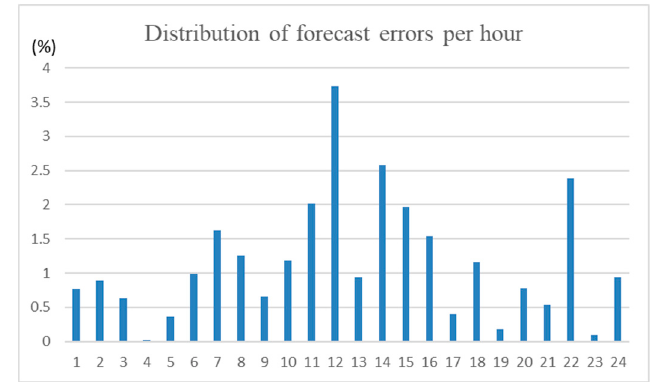
Figure 11. Distribution of forecast errors of 19 November 2016 forecasting.